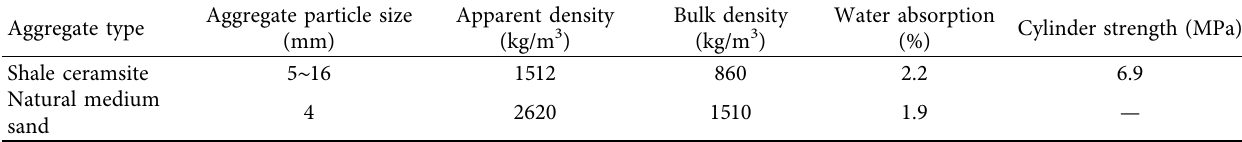
Table 1: Basic properties of aggregates.